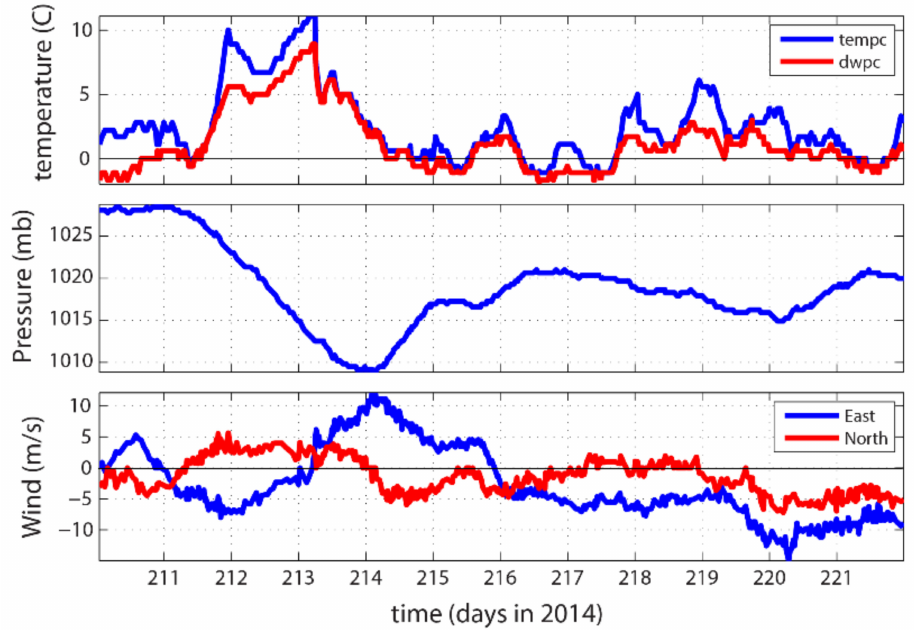
Figure 10. Weather time series data from the Barrow airport automated surface observation system (ASOS). The upper, middle, and lower panels are for the air temperature and dew point temperature, air pressure, and wind velocity components (east and north components); 2 August 2014 is day 214 starting from 1